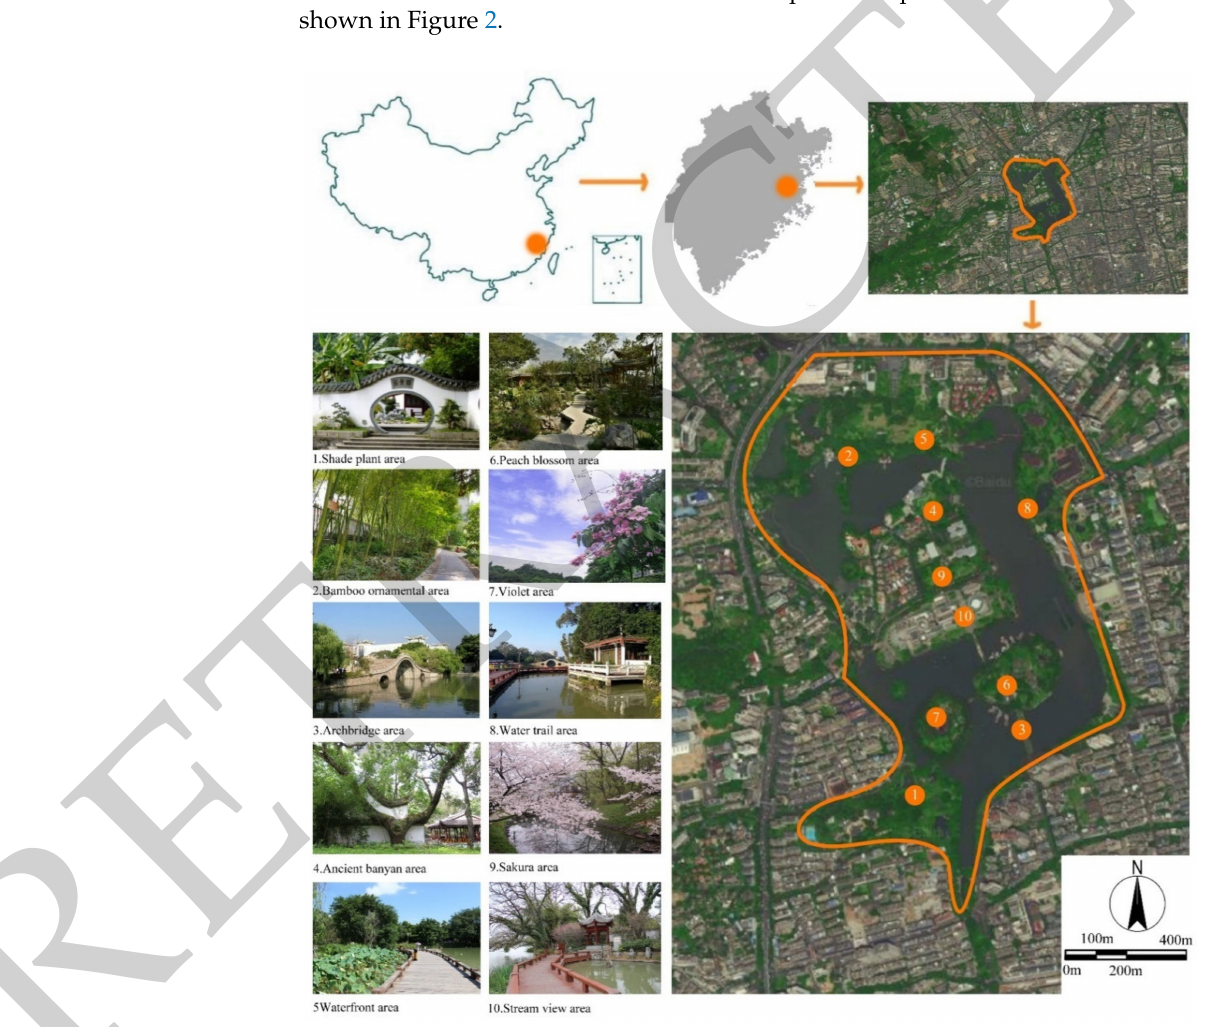
Figure 2. Map and aerial photos of the study area, site selection photographs, and plan view of Fuzhou West Lake